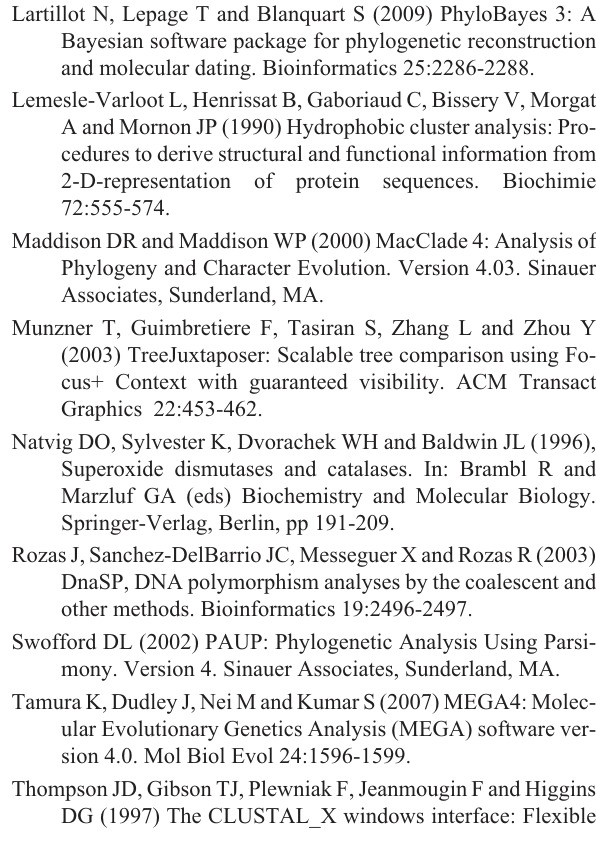
Figure S1 C Bayesian tree for MnSOD proteins. Figure S2 - Maximum Likelihood tree for MnSOD proteins. Figure S3 - Neighbor Joining tree for MnSOD proteins. Figure S4 - Maximum Parsimony tree for MnSOD